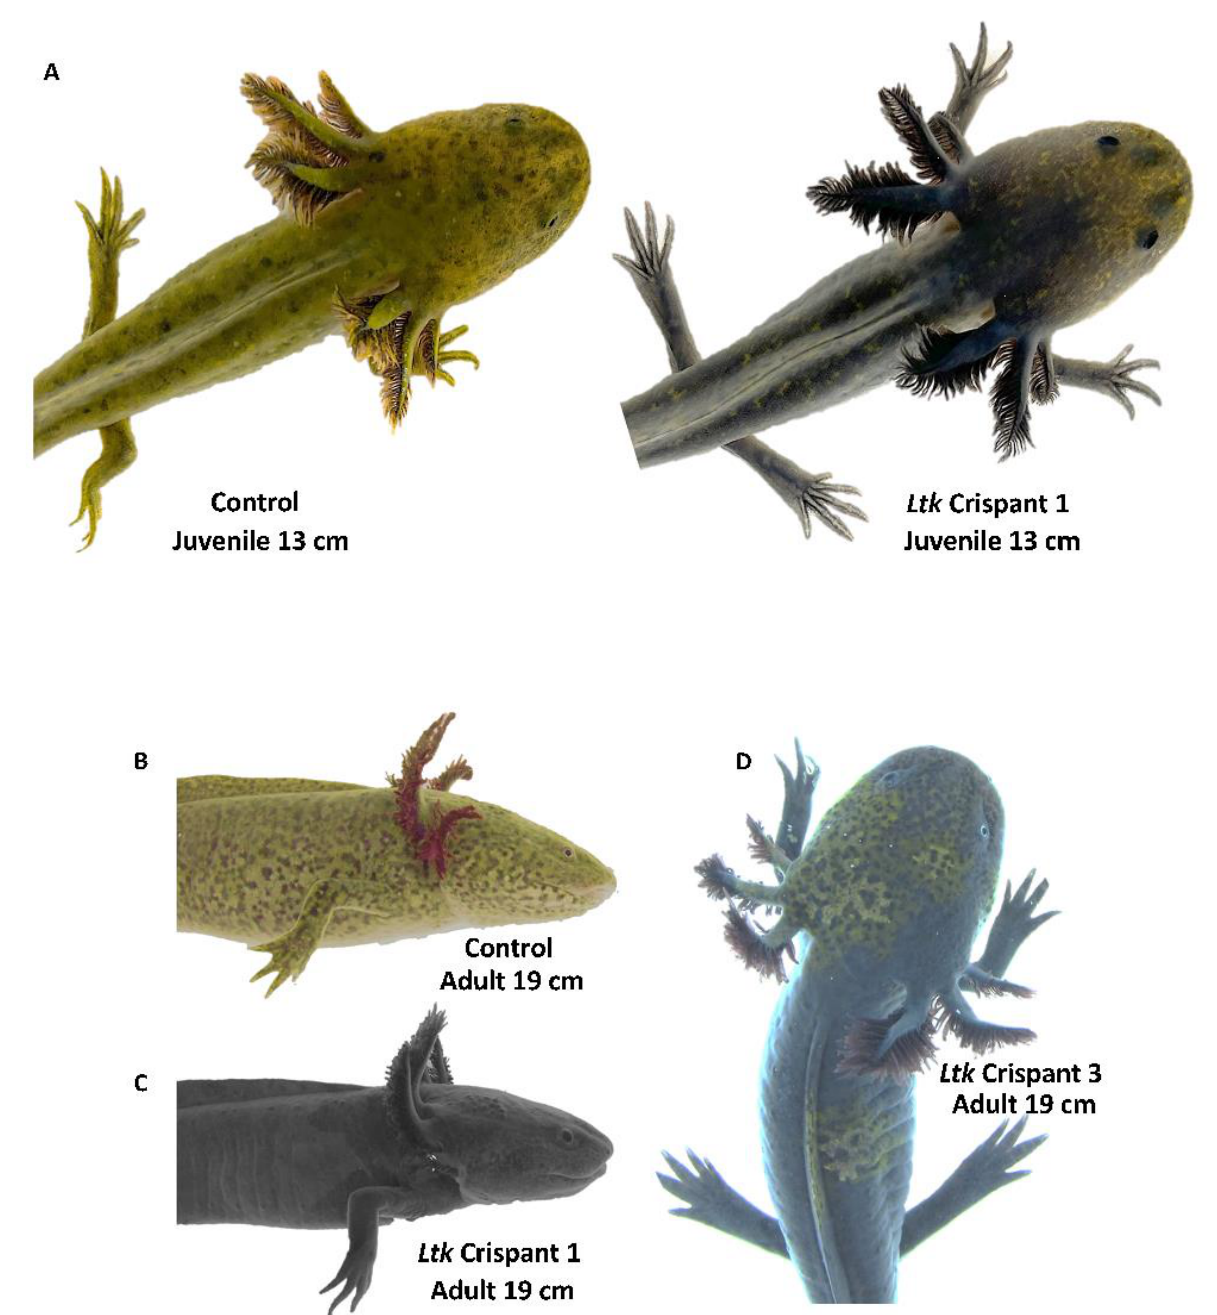
Figure 5. CRISPR-Cas9 editing of Ltk . ( A ) Examples of control non-injected and gRNA-injected ( Ltk Crispant 1) individuals at the juvenile stage. ( B ) Adult control wild type with melanophores, xanthophores, and iridophore-pigmented eyes. ( C ) Adult Ltk Crispant 1 with melanophores masking xanthophores and no iridophores in the eye. ( D ) Adult Ltk Crispant 3 with melanophores, patches of xanthophores, and iridophore-pigmented right eye.